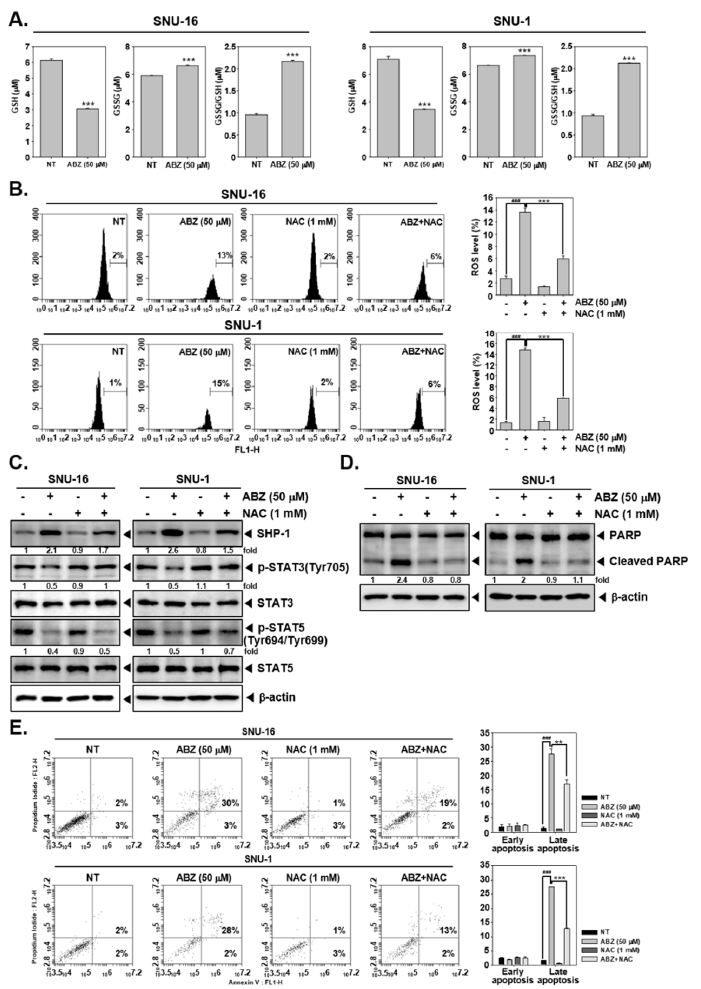
Figure 6. Regulation of ROS production by ABZ. ( A ) SNU-16 and SNU-1 cells were treated with ABZ 50 µM for 12 h and GSH/GSSG assay was carried out. ( B ) Cells were pre-treated with NAC 1mM for 15 min, then incubated with ABZ 50 µM for 12 h. and ROS production was measured ( C ) Cells